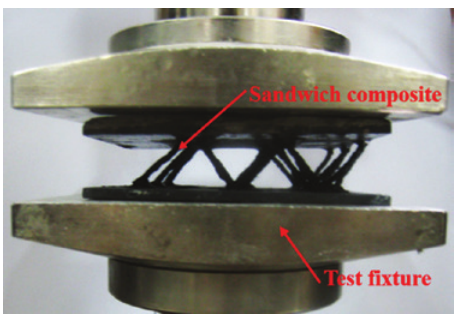
Figure 7: Test schematic of the sandwich composites subjected to quasi-static out-of plane compression loads.